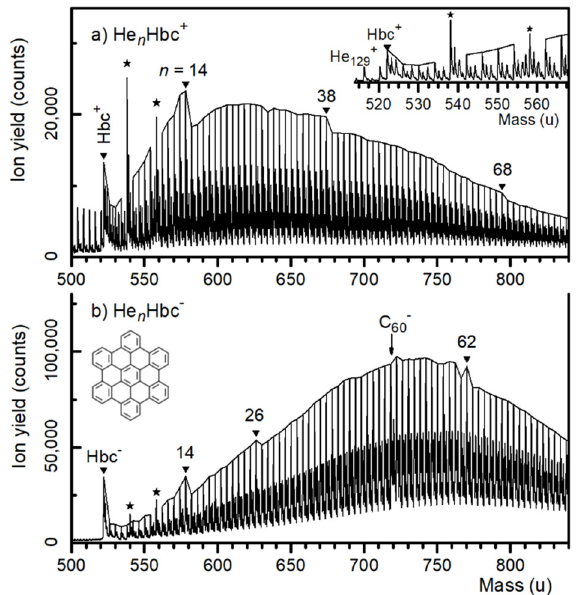
Figure 1. ( a ) Mass spectrum of hexabenzocoronene (Hbc) cations complexed with helium. The inset displays a narrow section of this spectrum. Mass peaks arising from contaminants are marked by asterisks. Mass peaks due to the main isotopologue of He n Hbc + are connected by a solid line; local anomalies are indicated. ( b ) Similar to panel ( a ) for negatively charged ions.